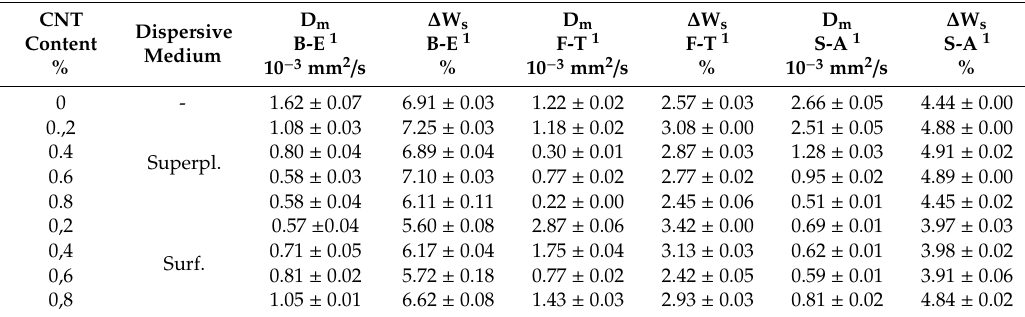
Figure 9. Effect of exposure state on the ( a ) water absorption, and ( b ) gas permeability profiles of un-modified mortars . Table 2. Di ff usion coe ffi cient, D m and relative weight gain at saturation, ∆ W s , as a function of CNT content, dispersive medium and exposure